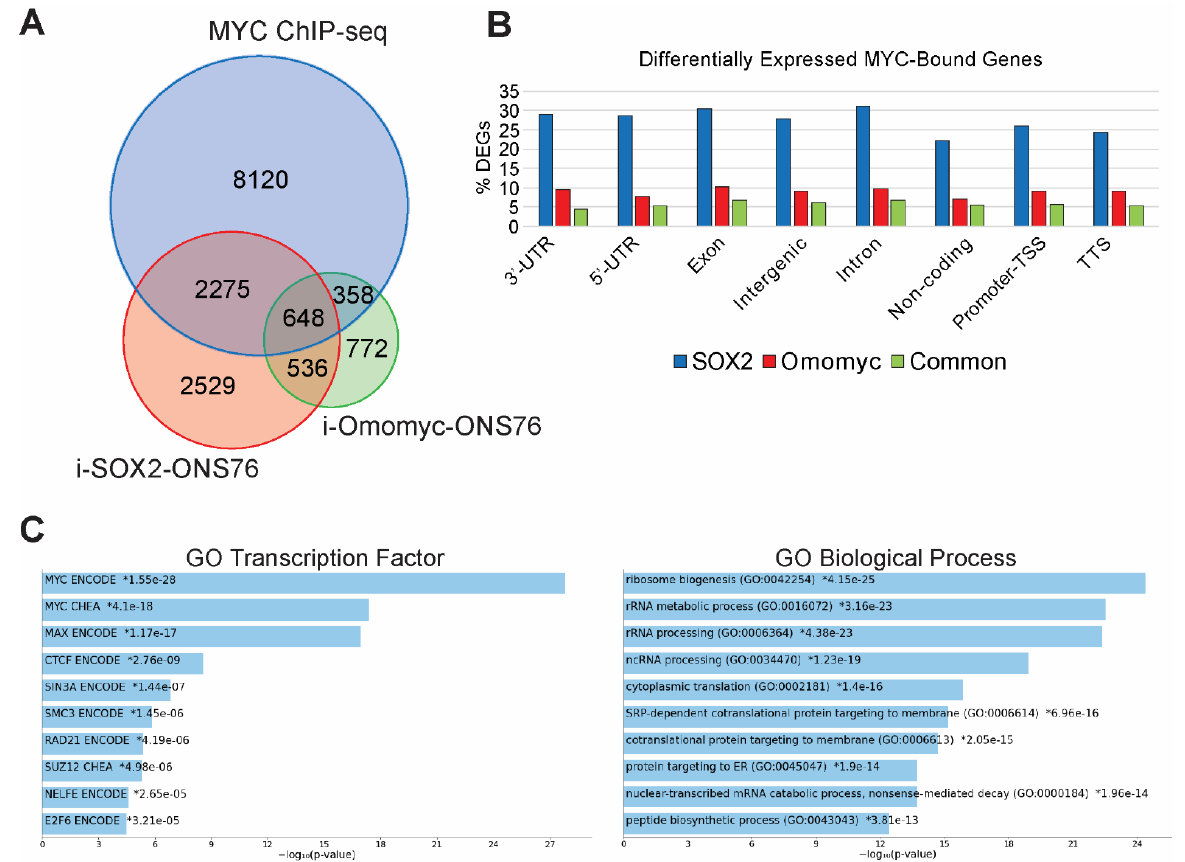
Figure 5. SOX2 and MYC regulate ribosomal biogenesis and protein translation genes in ONS76 cells. ( A ) Venn diagram showing the overlap of MYC-bound genes in ONS76 cells, i-SOX2-ONS76 DEGs, and i-Omomyc-ONS76 DEGs. ( B ) Percentage of MYC-bound genes differentially expressed in i-SOX2-ONS76, i-Omomyc-ON76, or both, based on the location of the MYC-binding peak. ( C ) TOP 10 GO Transcription Factor (ENCODE and CHEA) and Biological Process enrichment categories for common genes bound by MYC and differentially expressed in i-SOX2-ONS76 and i-Omomyc-ONS76 cells.